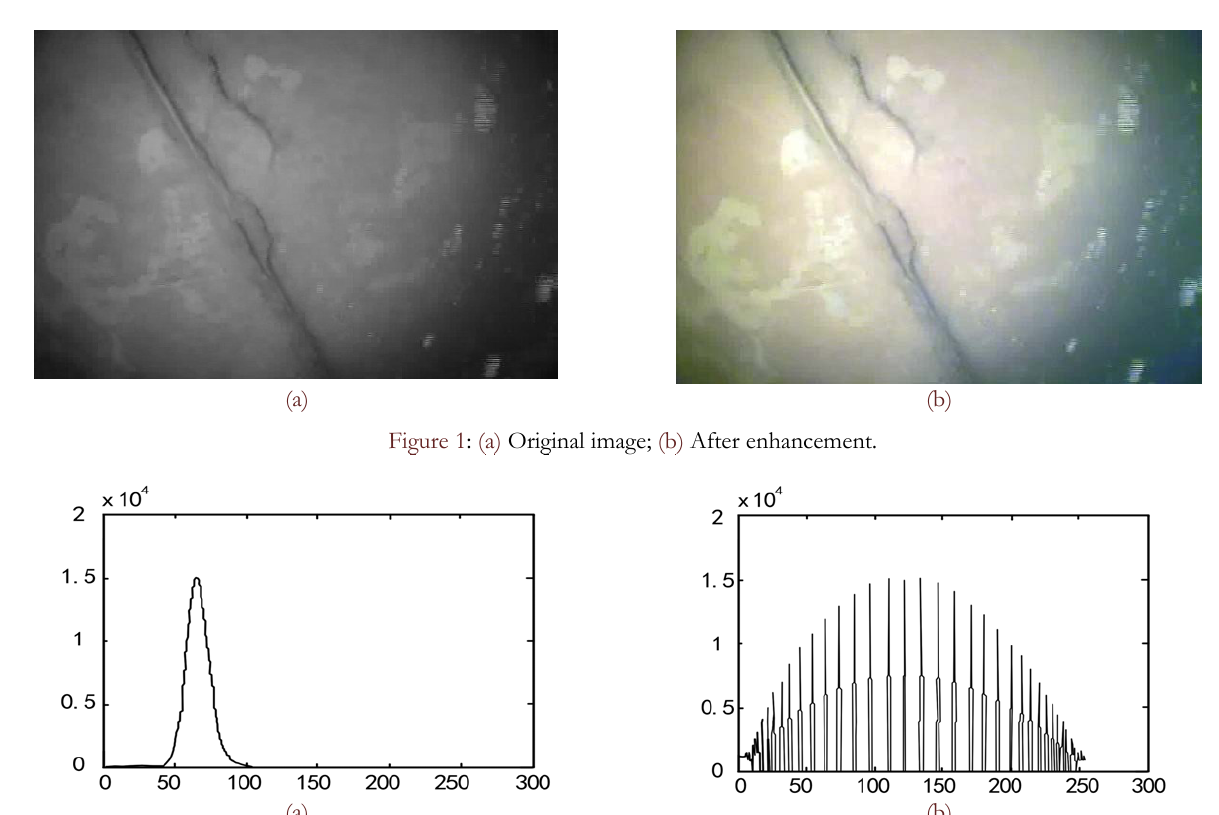
Figure 2: (a) Original image’s gray histogram; (b) Gray histogram after